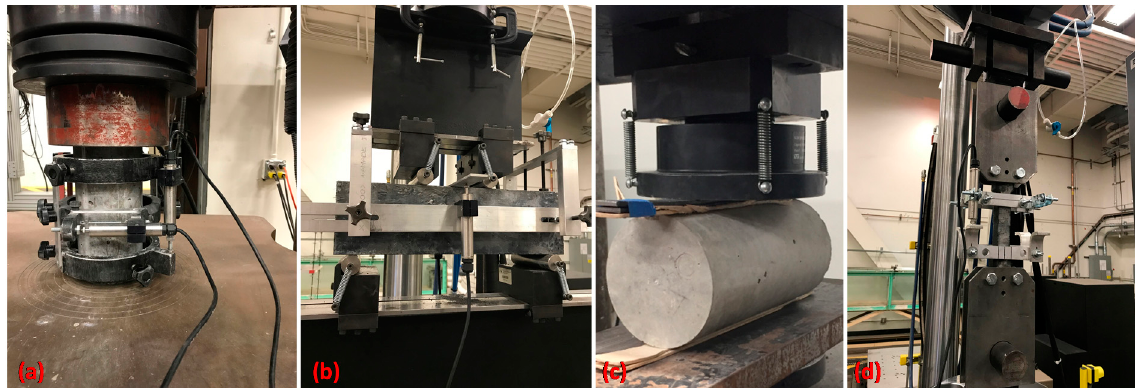
Figure 3. Material tests ( a ) compression, ( b ) flexure, ( c ) split tension, and ( d ) uniaxial tension on NSC and UHPC. Note that uniaxial tension tests were only performed on UHPC samples.